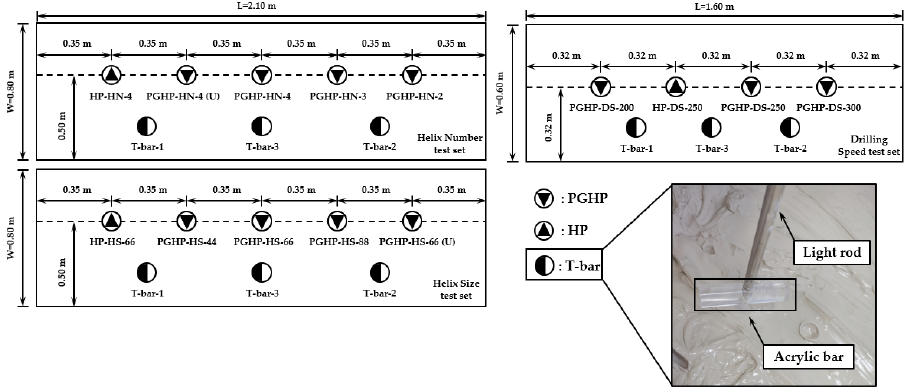
Figure 4. Layout of the small-scale piles in each test set. Table 3. Summary of geotechnical properties of kaolinite clay.